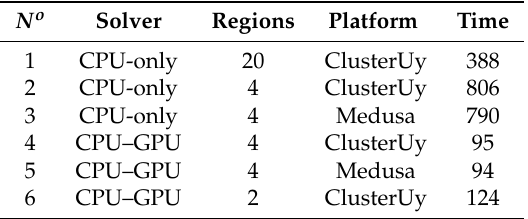
Table 3. Computation times (minutes) for computing 1000 timesteps of the